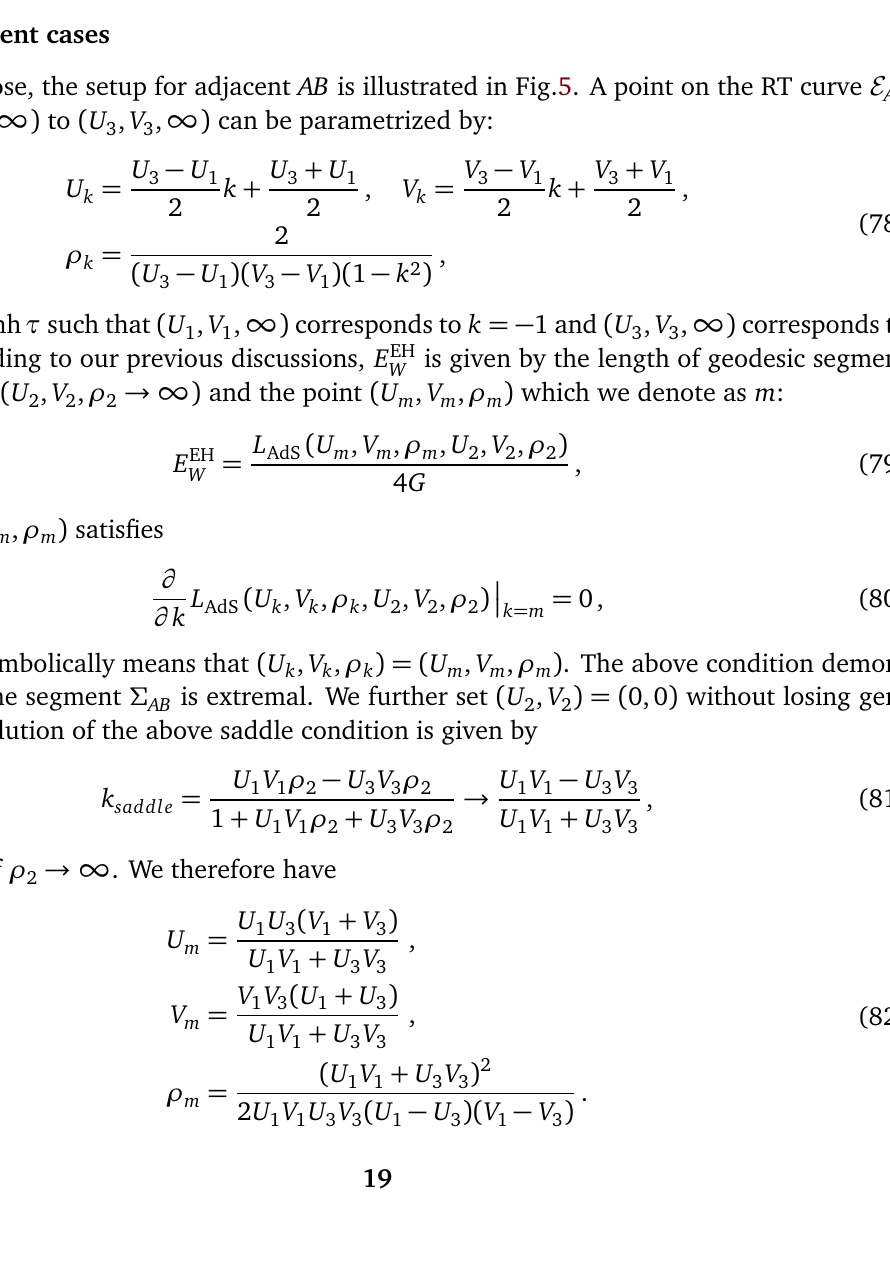
AB ) . The vector , x 0 0 ∝ ∂ , while n AB b t